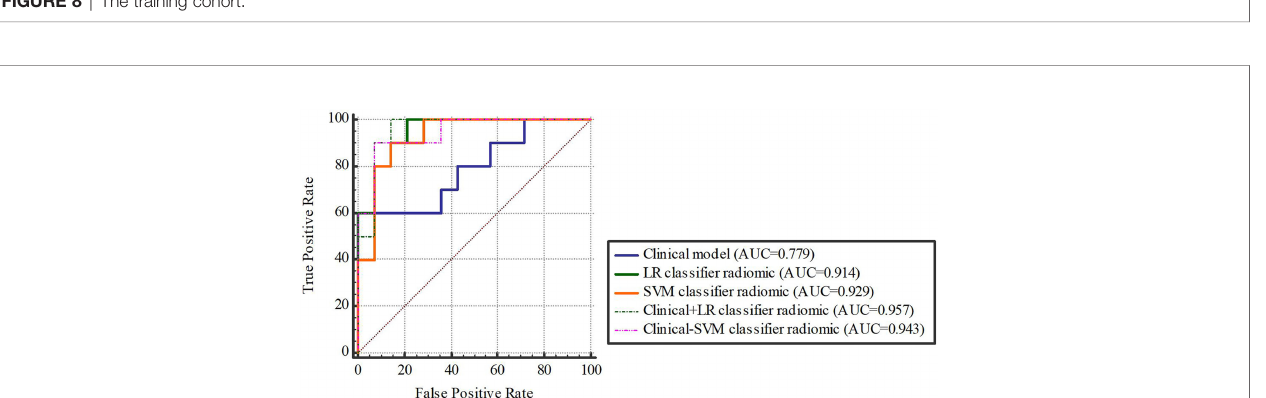
FIGURE 8 | The training cohort.